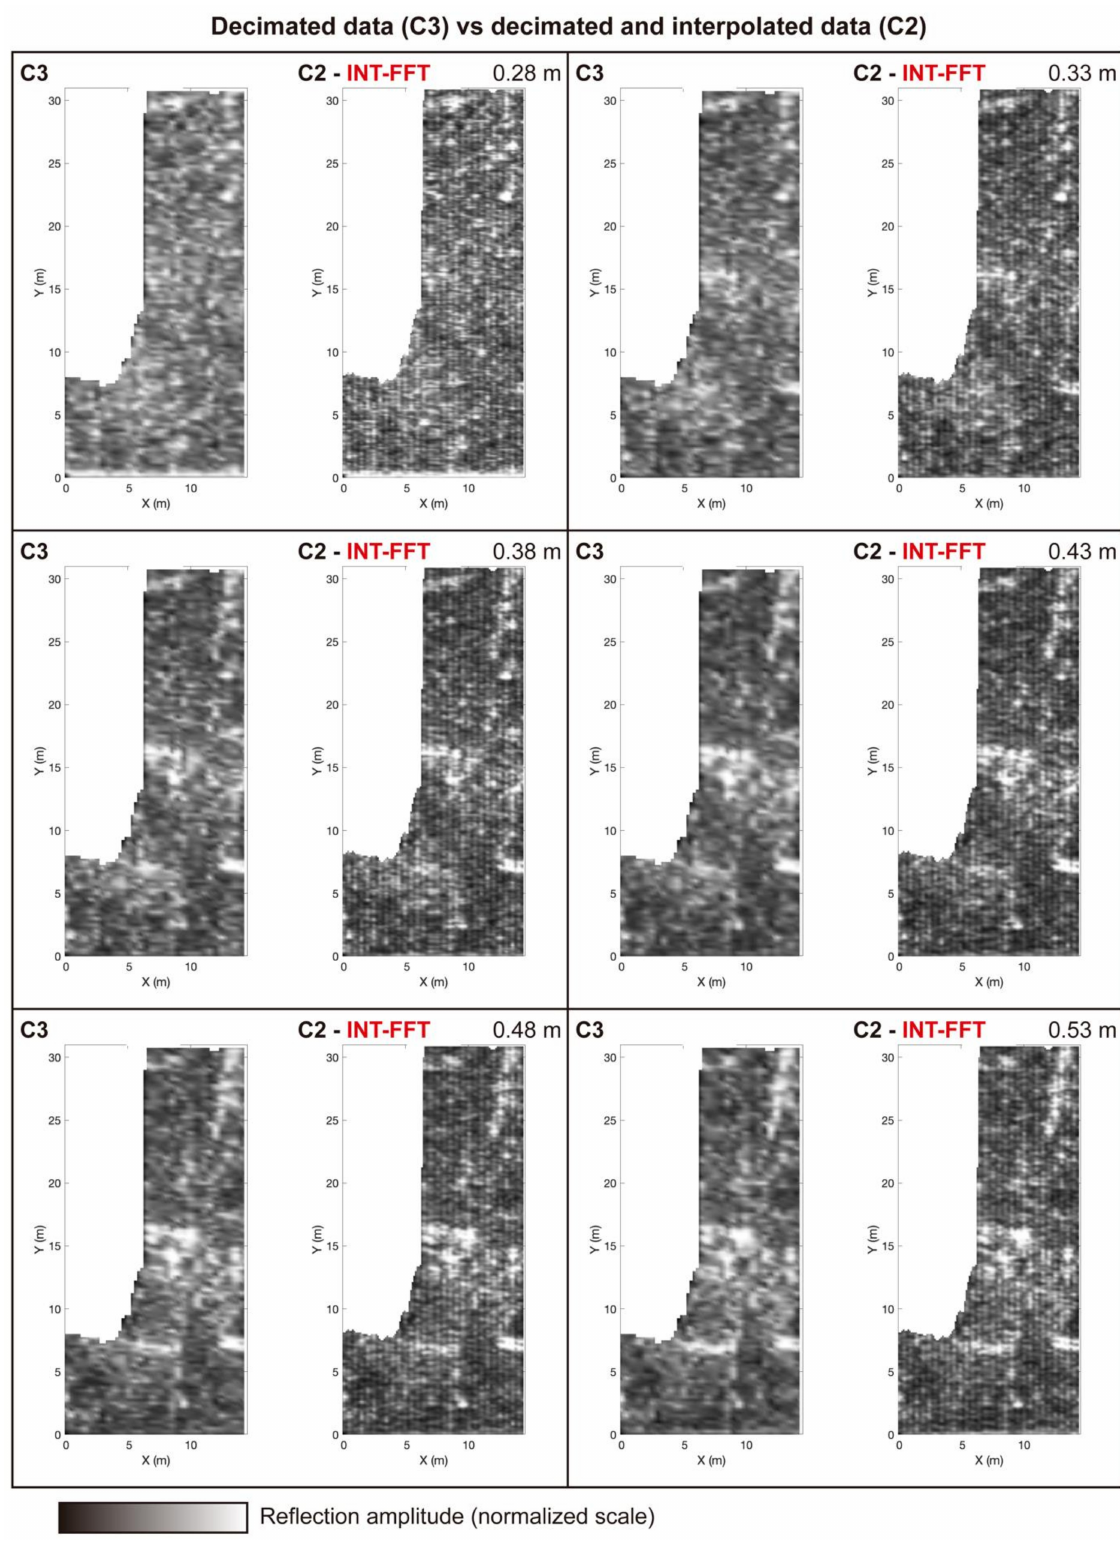
Figure 10. Differences between the decimated data (C3—d = 0.500 m) and the decimated and interpolated data (C2—d = 0.250 m). We can assess information retrieval before and after interpolating data that we have previously